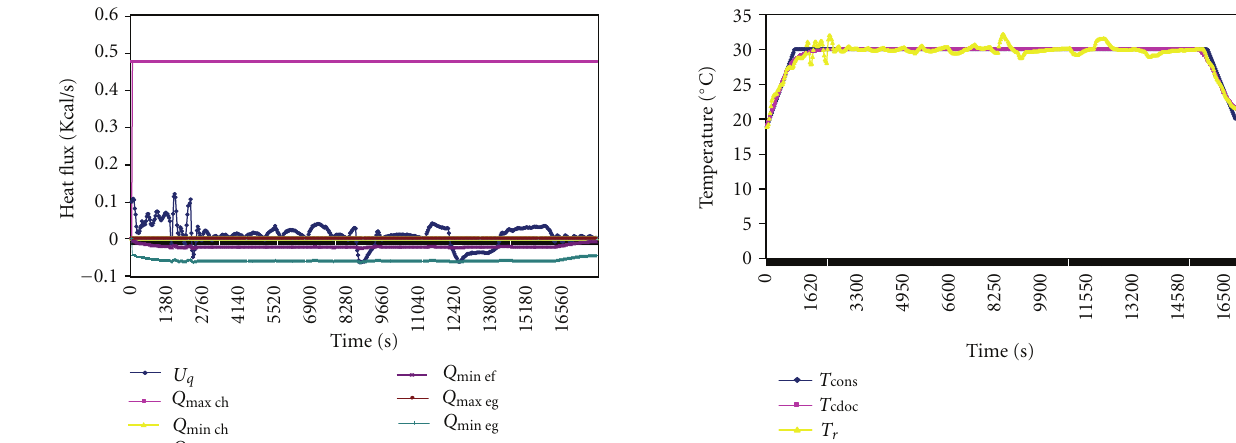
Figure 11: Evolution of thermal flux and limits thermal flux, K = 0.5, K r = 0.5.